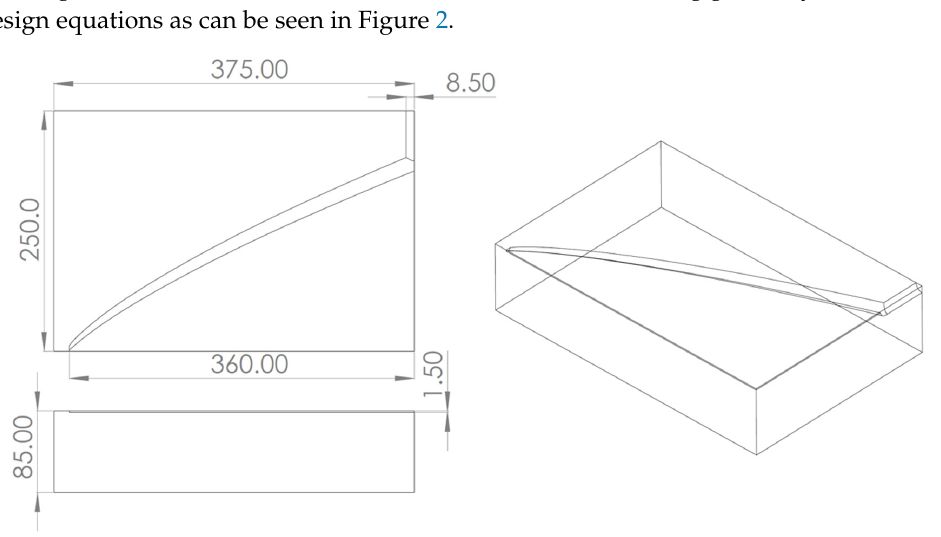
Figure 2. Casson model-based coat-hanger die geometry.